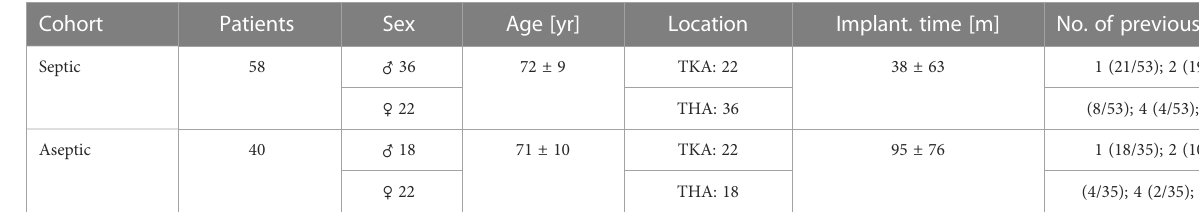
TABLE 1 Demographic